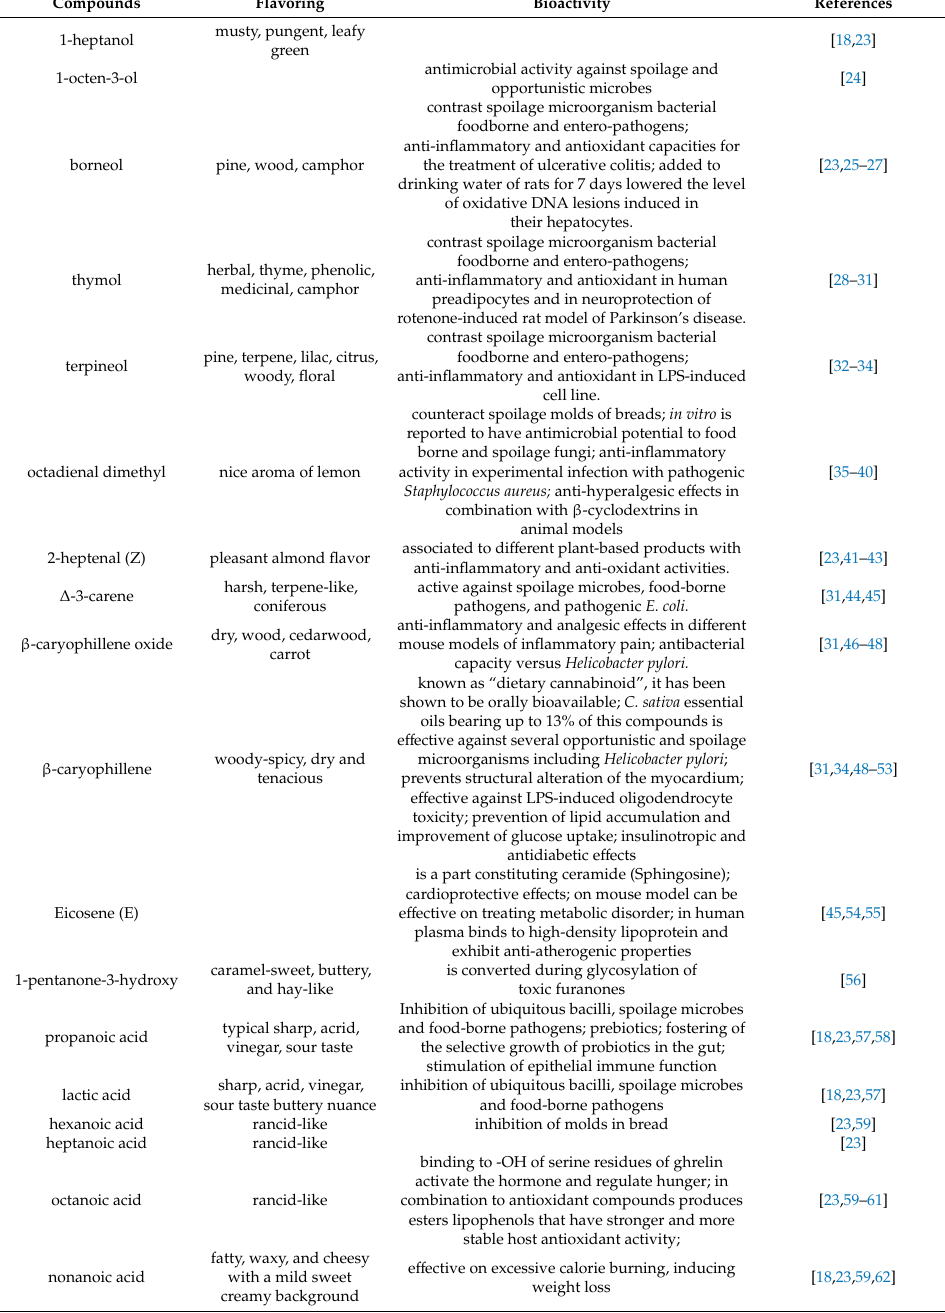
Table 4. Flavoring and bioactivity of discriminant VOCs of hemp seed flour (HSF) fermented doughs and